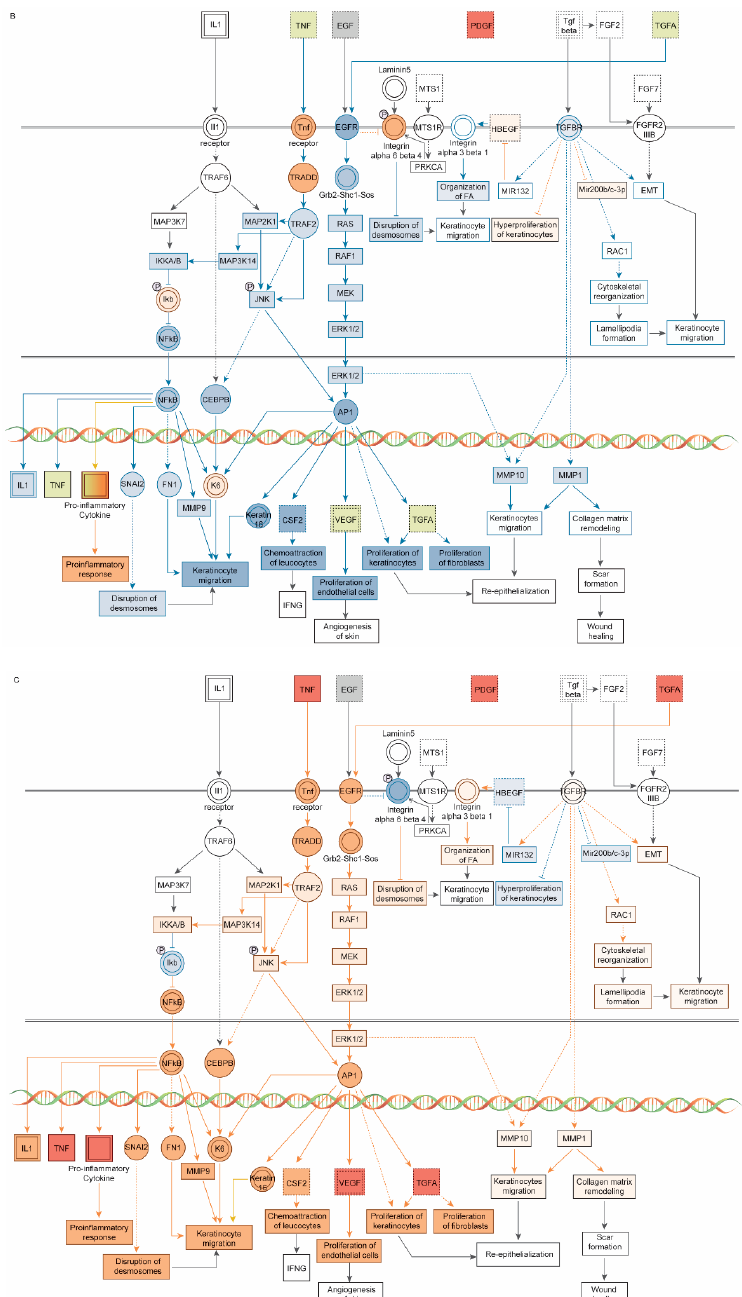
Figure 4. Schematic diagrams of the wound healing signaling pathway, prepared using Ingenuity Pathway Analysis software (IPA, Qiagen, Germantown, MD), showing both inhibited and activated pathway signaling in HEPM cells 48 h after ( A ) 255 nm irradiation, ( B ) 405 nm irradiation, and ( C ) 255/405 nm irradiation. Signaling starts via TNF binding to the TNF receptor; EGF and TGFA bind- ing to the EGFR; and TGFB binding to the TGFBR. These pathways signal through TRADD and TRAF2 to JNK and through RAS, RAF, and MEK to ERK1/2. Signaling continues to NF- κ B, CEBPB, and AP-1 to activate additional CCBMs, leading to proinflammatory responses, disruption of des- mosomes, chemoattraction of leukocytes, migration and proliferation of fibroblasts and cells, colla- gen matrix remodeling, and wound healing pathways. Pathway molecules in red indicate activation and molecules in green indicated inhibition. Signaling connections in orange indicate pathway ac- tivation and signaling connections in blue indicate pathway inhibition .